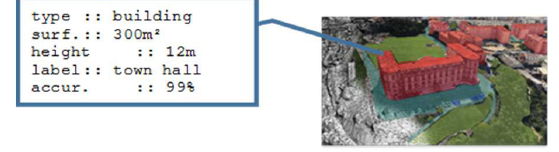
Fig. 1. 3D maps and